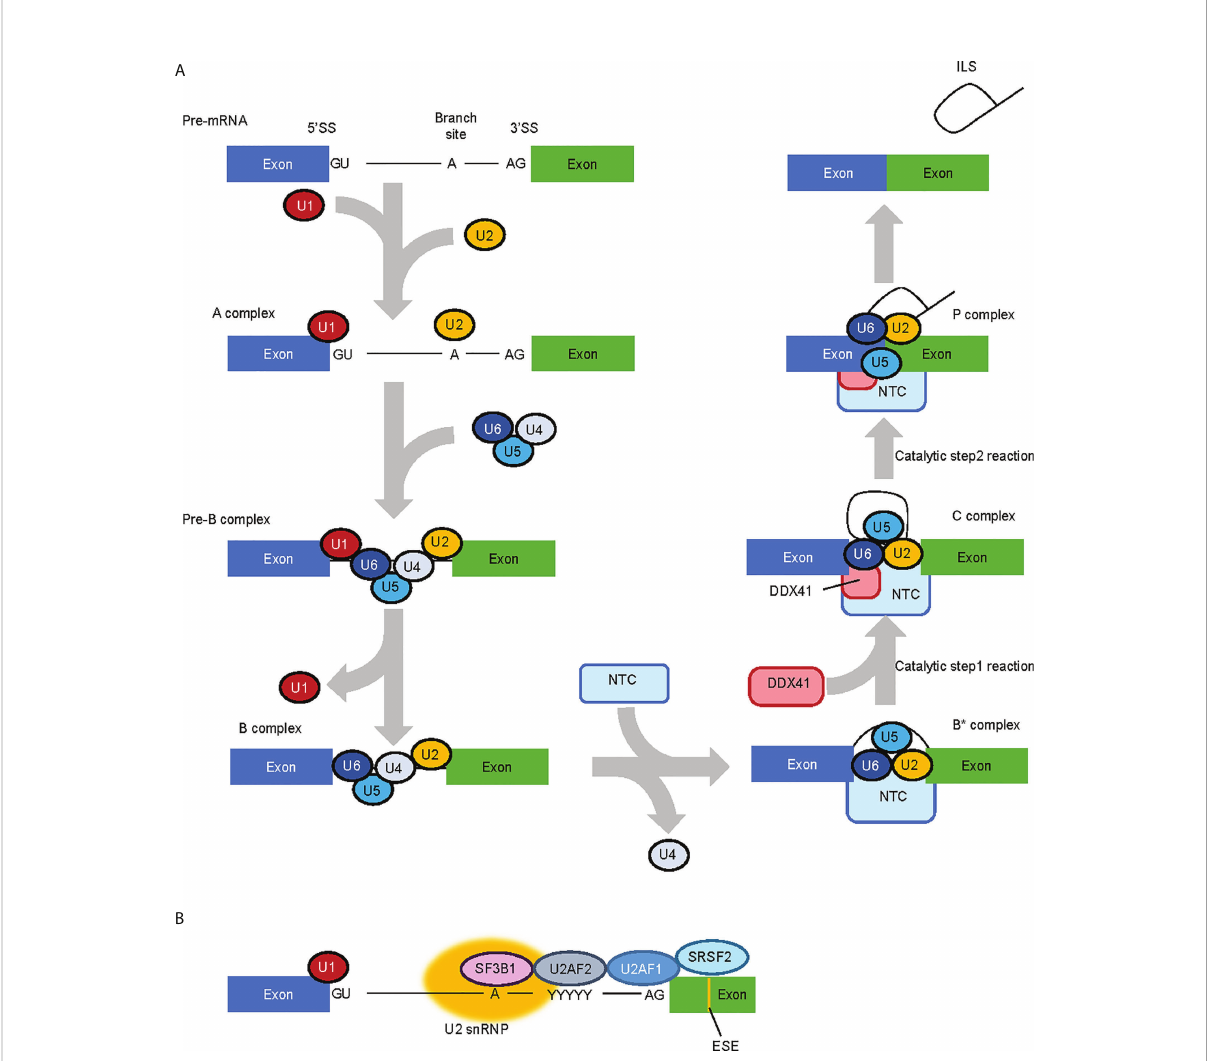
FIGURE 2 RNA splicing process and factors involved in the process. (A) Simpli fi ed RNA splicing process. The 5 ’ splice site (SS) and branch site of transcribed pre-mRNA are fi rst recognized by U1 snRNP and U2 snRNP, respectively. U4/U6.U5 tri-snRNP is then recruited while U1 snRNP and U4 snRNP are released in a stepwise manner. The NineTeen Complex (NTC), consisting of 7 core NTC proteins and 14 NTC-associated proteins, is recruited to (and regulates the conformaiotn of) the spliceosome. In the catalytic Step 1 reaction, the 2 ’ -OH of adenine in the branch site attacks the 5 ’ SS and cleaves the RNA to form an intron lariat, and in the Step 2 reaction, the 3 ’ -OH at the 3 ’ end of the free 5 ’ exon attacks the 3 ’ SS and cleaves the RNA. DDX41 is likely recruited to the spliceosome at the C complex phase. (B) MDS-related RNA splicing factors. SF3B1 is involved in branch site recognition, U2AF1 in 3 ’ SS recognition and SRSF2 in exonic splicing enhancer (ESE) recognition, respectively. Therefore, most of the mutations in MDS-related RNA splicing factors are concentrated in factors involved in 3 ’ SS